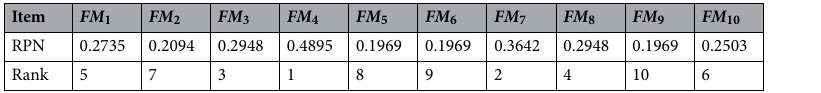
Table 8. RPN values and the ranking result.